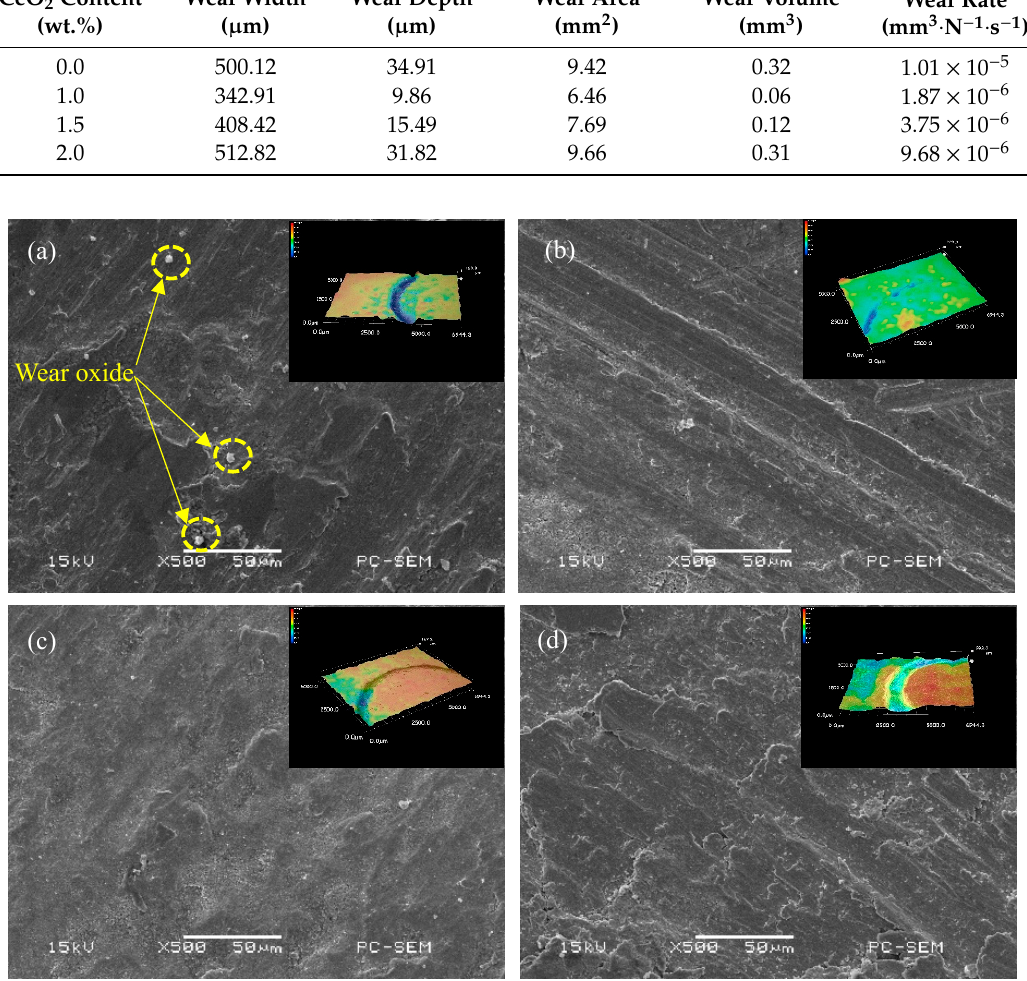
Figure 8. Wear micro-morphology and three-dimensional morphology of coatings with different CeO